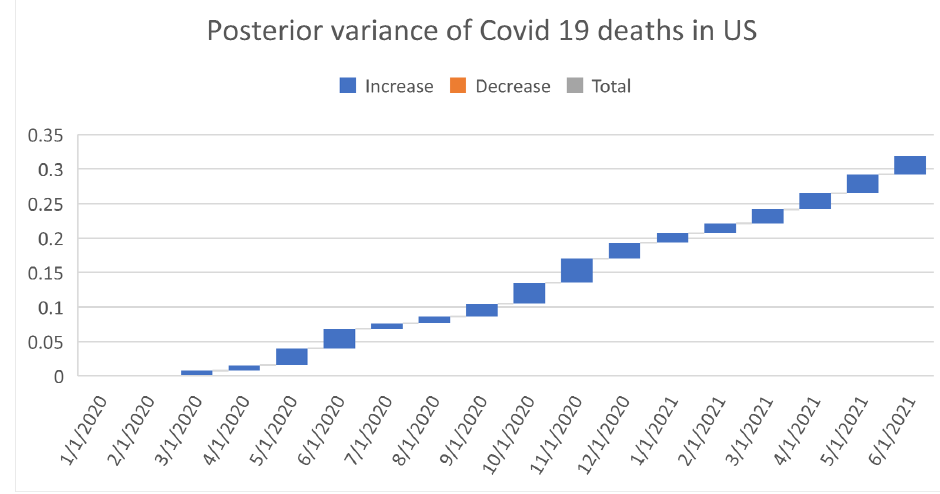
Figure 12. Progressive variance of COVID ‐ 19 deaths in US. For readability, note that 4/1/2020 refers 1 April 2020.